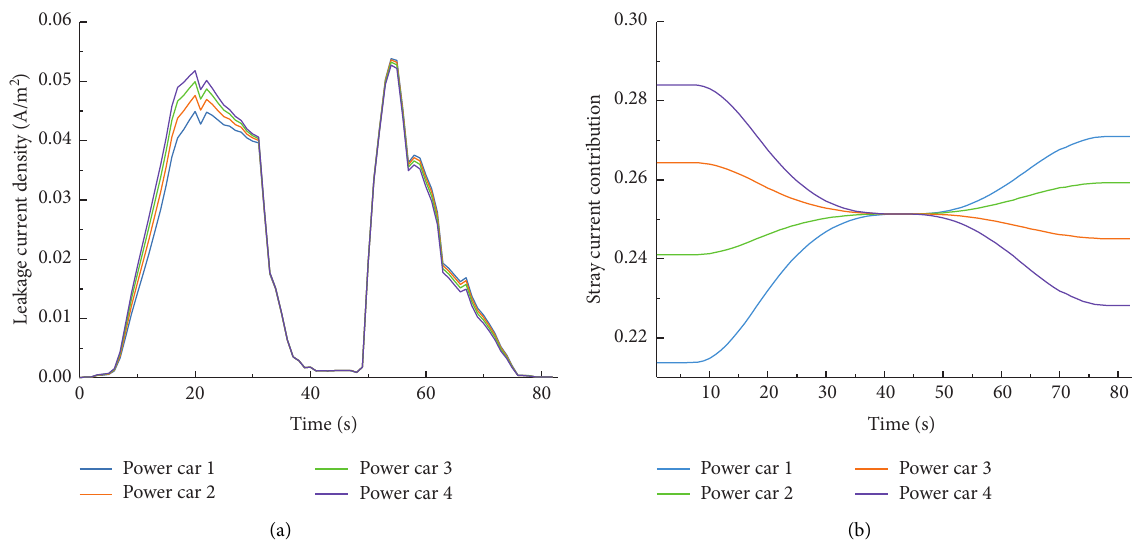
Figure 7: Analysis of the influence of each power car on stray current in the multiparticle model 1. (a) Leakage of each power car. (b) Contribution of power car.